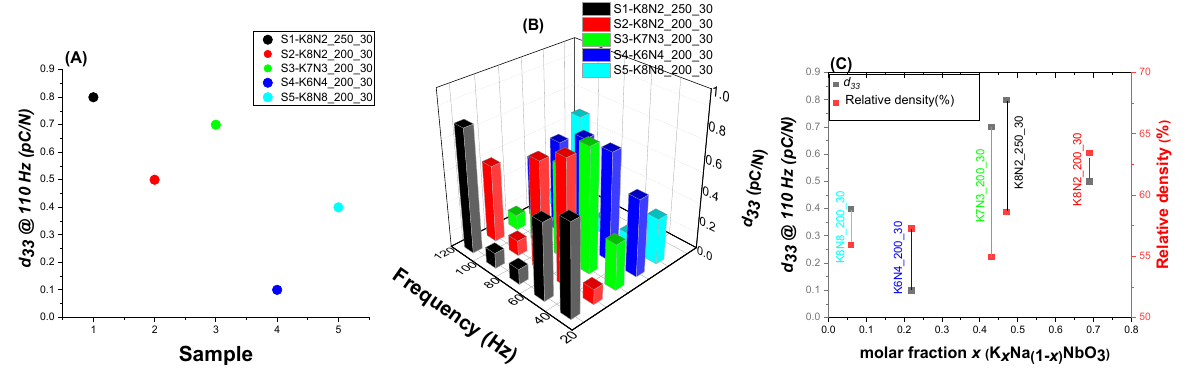
Figure 14. Piezoelectric constant d 33 ( A ) for K8N2_250_30 (S 1), K8N2_200_30 (S 2), K7N3_200_30 (S 3), K6N4_200_30 (S 4) and K8N2_200_30 (S 5) at 110Hz; ( B ) d 33 variation with frequency (30–110 Hz); ( C ) d 33 variation with molar fraction x and the relative density of unsintered discs.